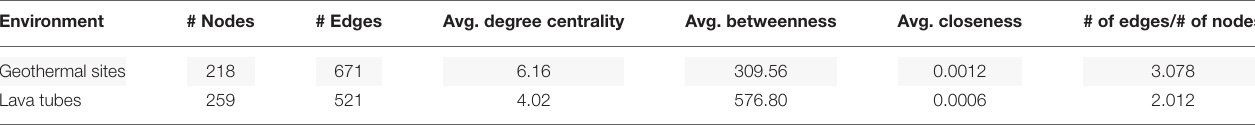
TABLE 1 | Network statistics comparing geothermal sites to lava